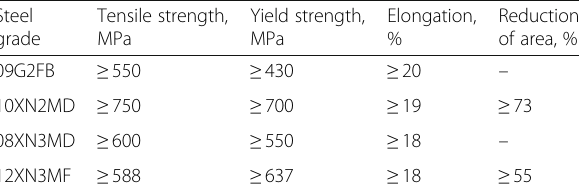
Table 2 Mechanical properties of studied steels (specification) Steel grade